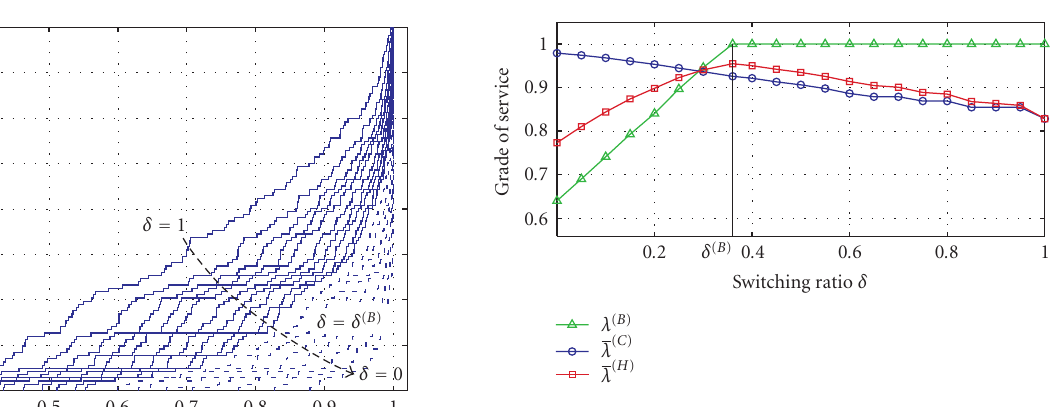
Figure 8: Grade of service of the entire network depending on the amount of load switching.